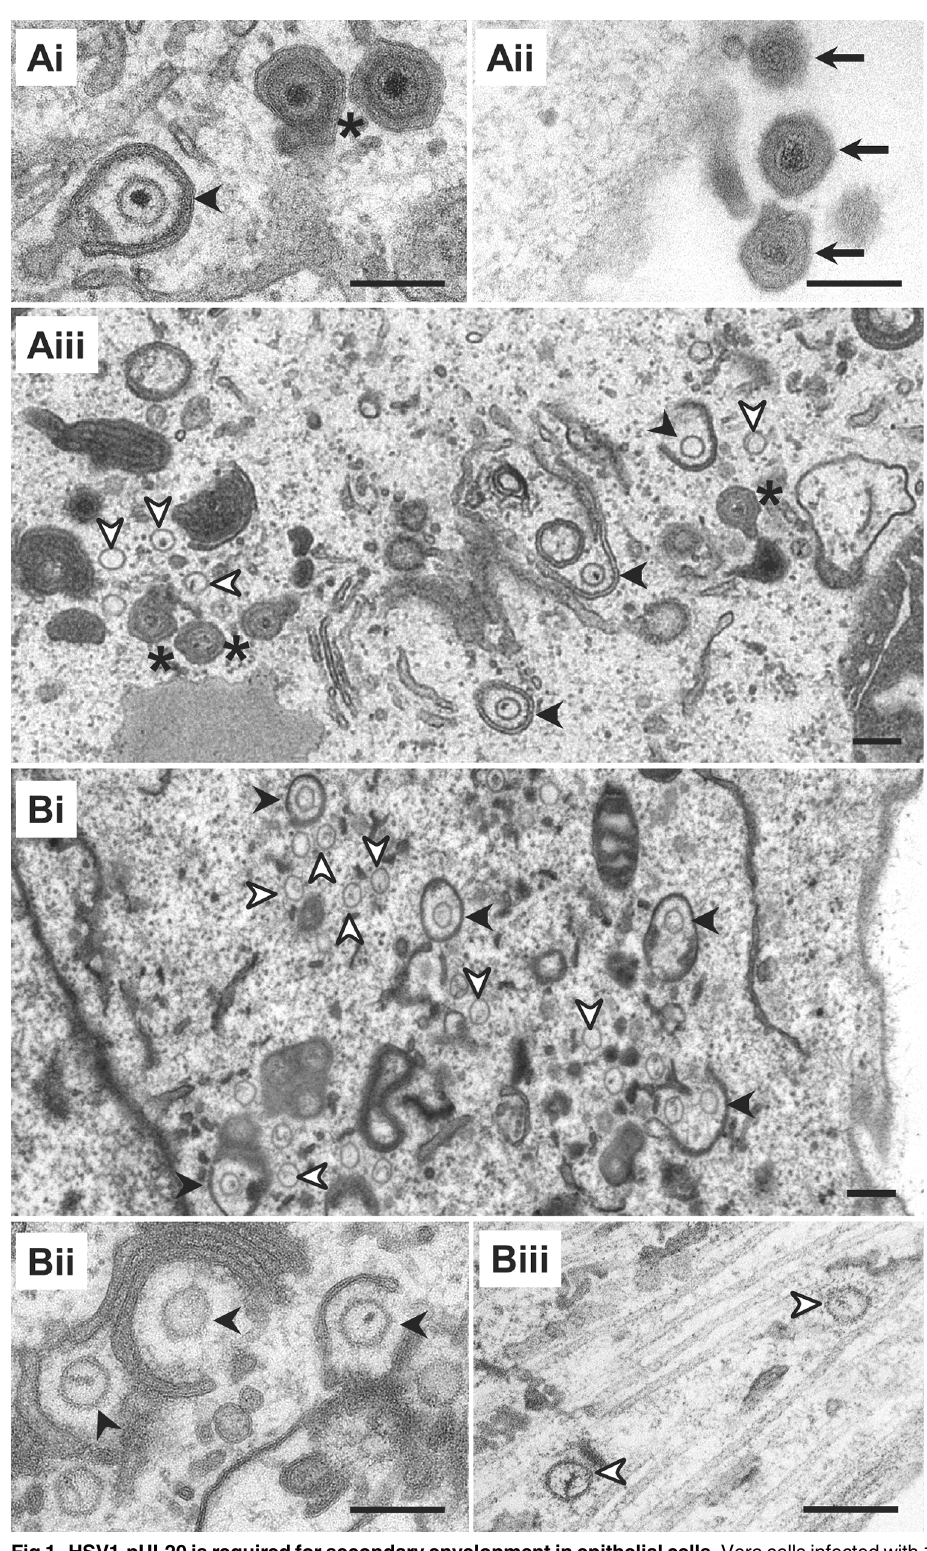
Fig 1. HSV1-pUL20 is required for secondary envelopment in epithelial cells. Vero cells infected with 1.9 x 10 6 pfu/mL (10 pfu/cell) of HSV1(17 + )Lox (A), - Δ UL20(Bi and Bii), or -CheVP26- Δ UL20(Biii), fixed at 14 hpi, and processedfor conventional electronmicroscopy. Cytosoliccapsids (white arrowheads),